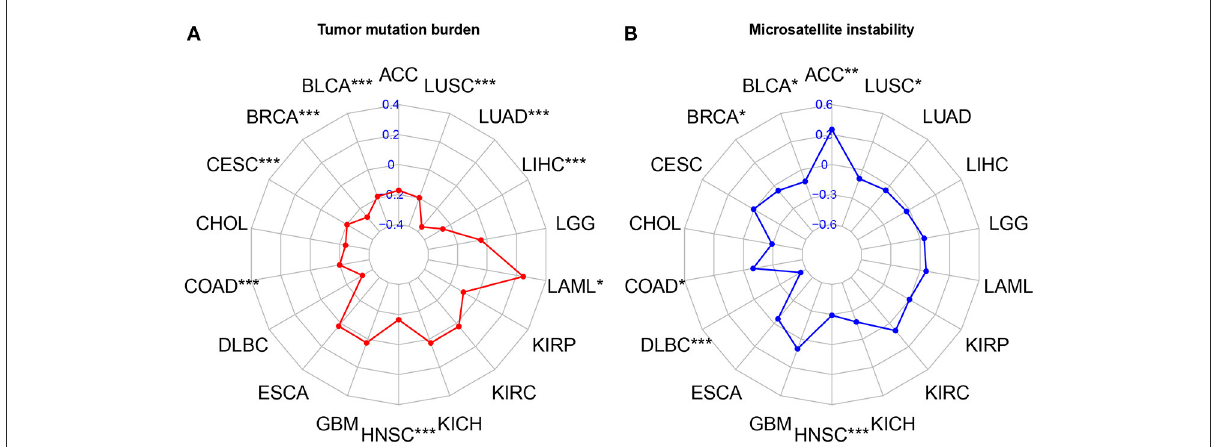
FIGURE5 Correlation analysis with TMB and MSI. (A) Correlation analysis of FAT4 expression and Tumor mutation burden. (B) Correlation analysis of FAT4 expression and Microsatellite instability. * P < 0.05, ** P < 0.01, *** P < 0.001.